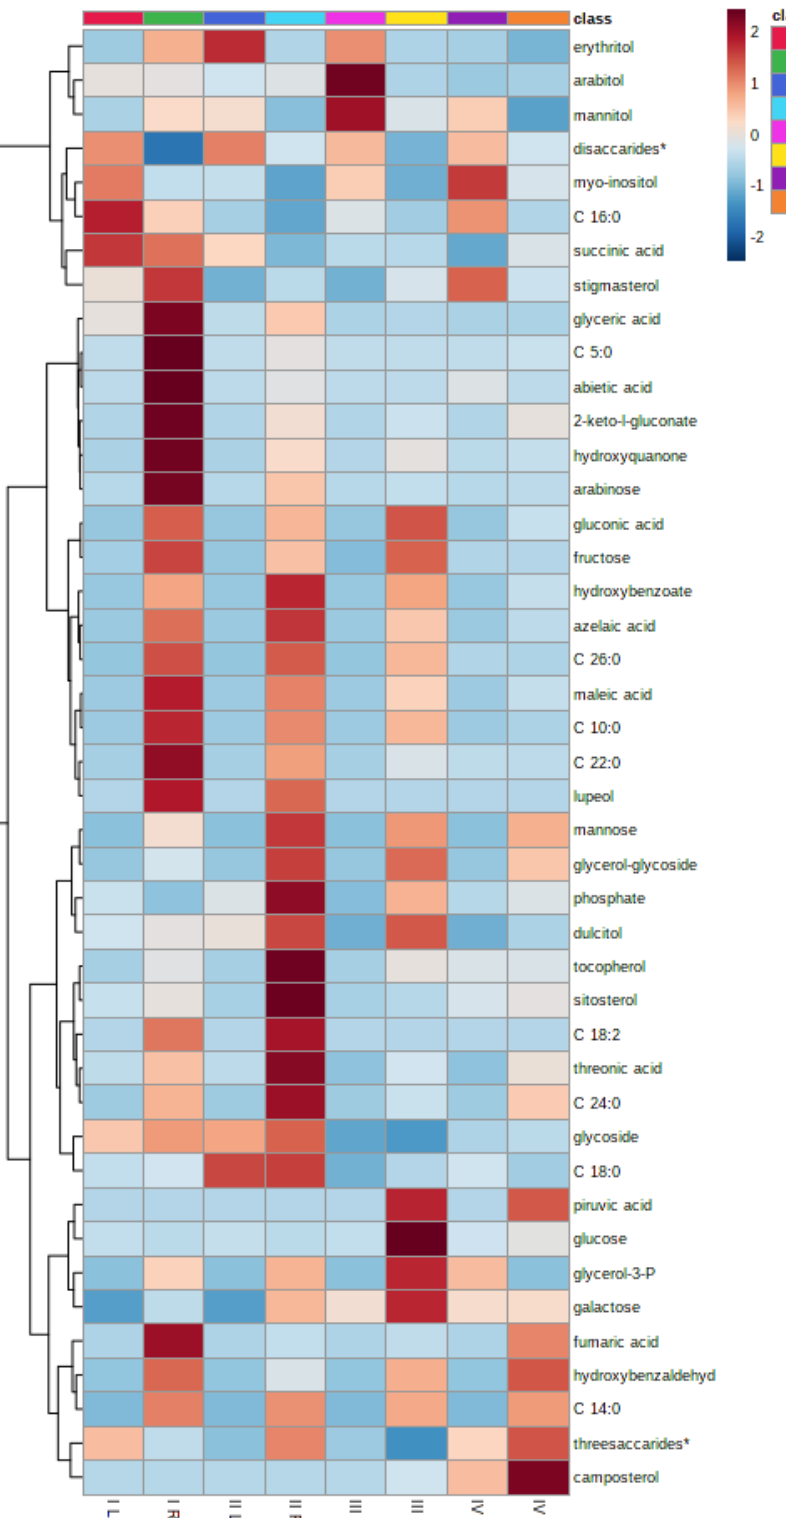
Figure 11. Heat map of united metabolome data of spring-summer samples of biolayers from Ruskeala quarry and museum necropolises (group average shown). Notes: R — Ruskeala quarry samples, L — museum necropolises samples, * — summarize concentration, P — pyranose, F — furanose.